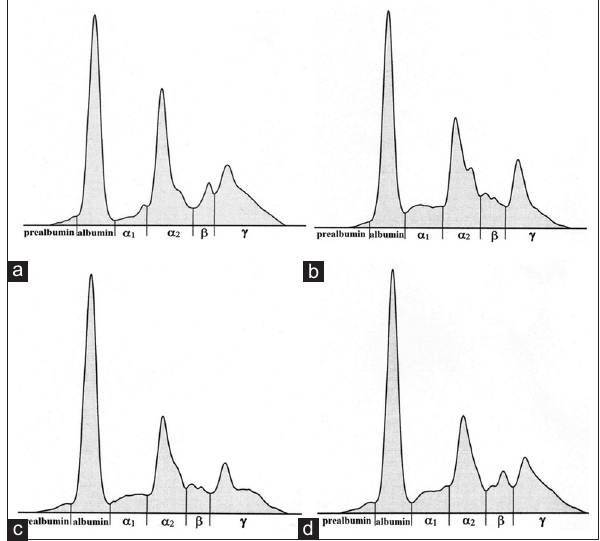
Figure-1: (a-d) Representative electrophoretograms from broilers showing the protein fractionation into six fractions: Pre-albumin, albumin, α -, α -, β-, and γ -globulins at 1 2 different age groups: (a) day 4; (b) day 18; (c) day 32, and (d) day